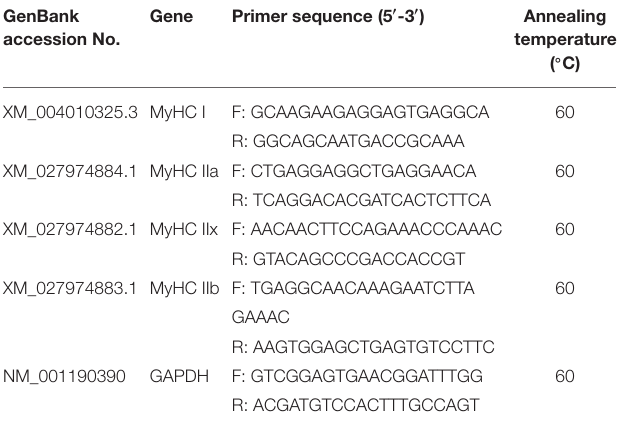
TABLE 1 | Primer sequences and annealing temperatures used for RT-qPCR. GenBank accession